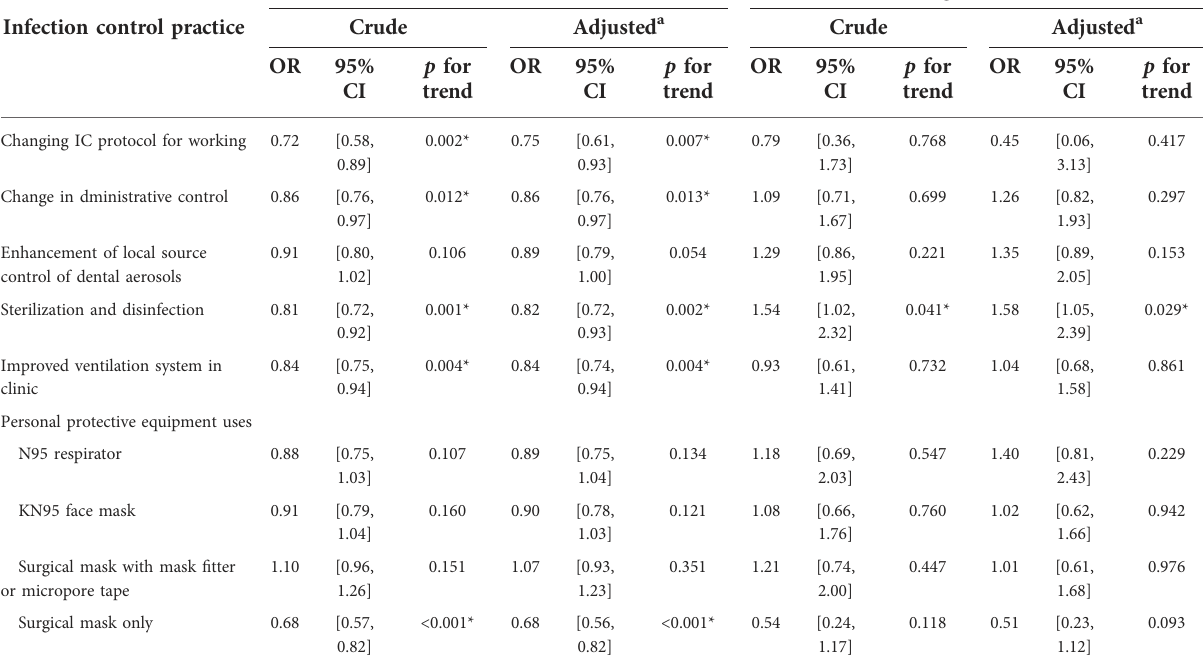
TABLE 2 Association between perception and infection control protocol was analyzed both in crude and adjusted models through logistic regression analysis ( N